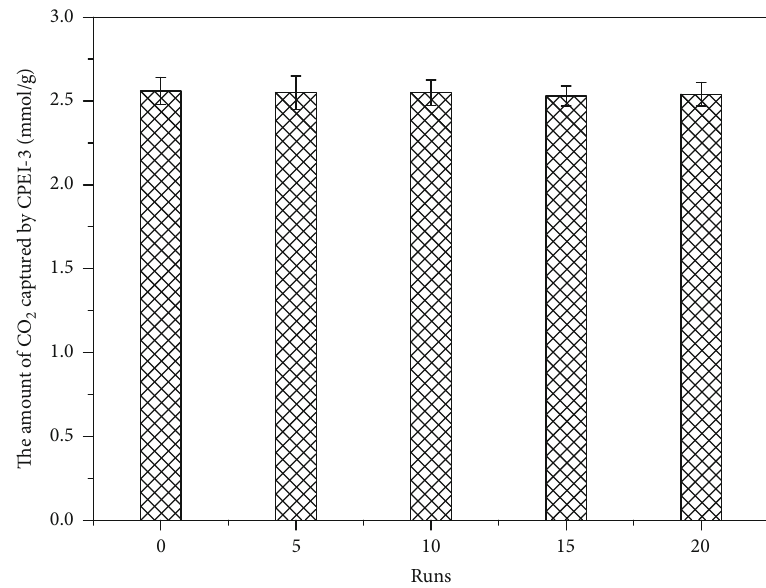
Figure 10: Reusability of the CPEI-3 sorbent for CO purging with N at 100 ° C for about 20min, until no CO 2